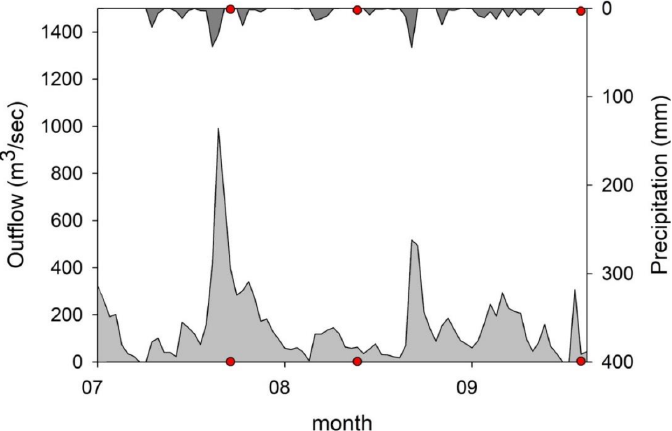
Figure 3. The amounts of outflow and precipitation. The red points indicate the dates on when samples were